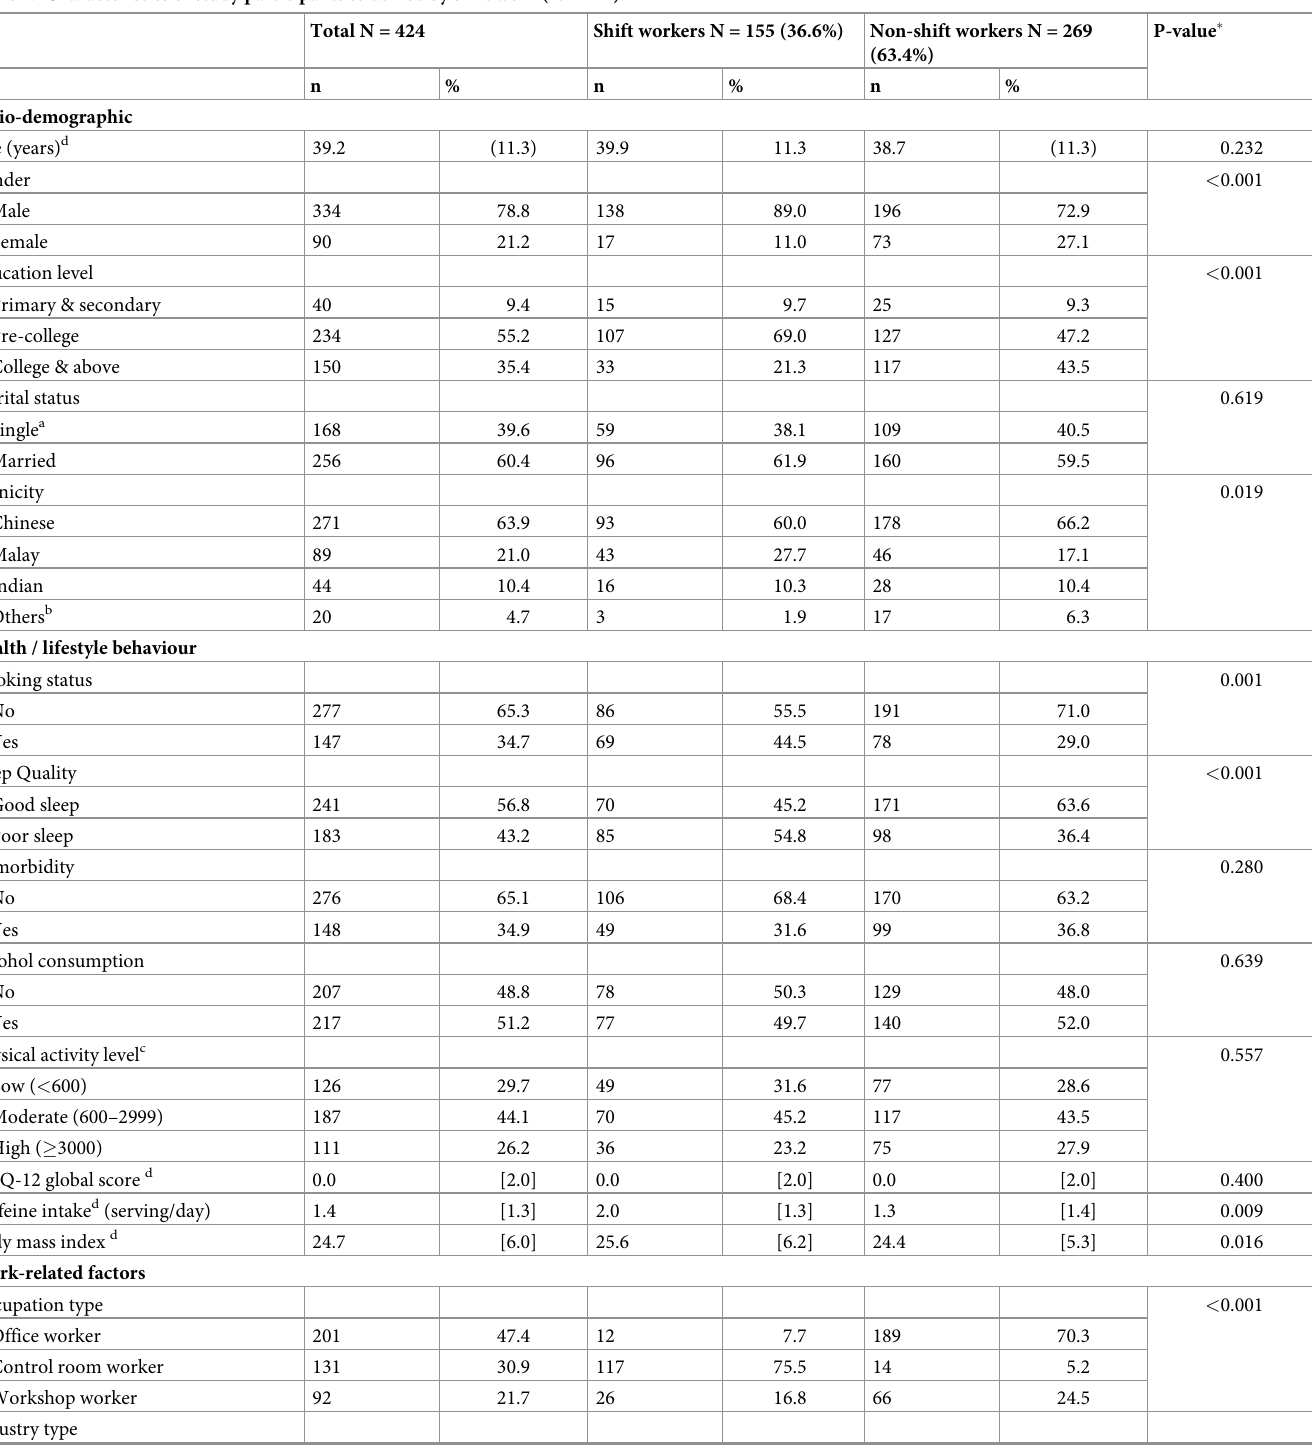
Table 1. Characteristics of study participants stratified by shift work (N =